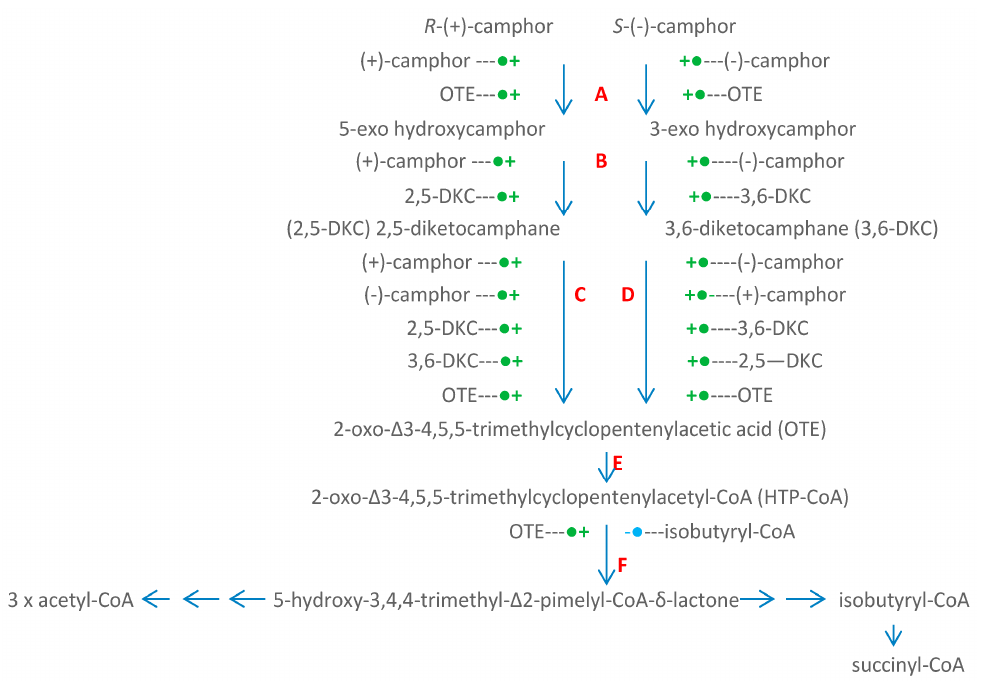
Figure 8. Transcriptional controls of the pathway of (+)- and ( − )-camphor degradation in P. putida ATCC 17453 --- ● + = induction: - ● --- = repression: A = cytochromeP450 monooxygenase ( camCAB ): B